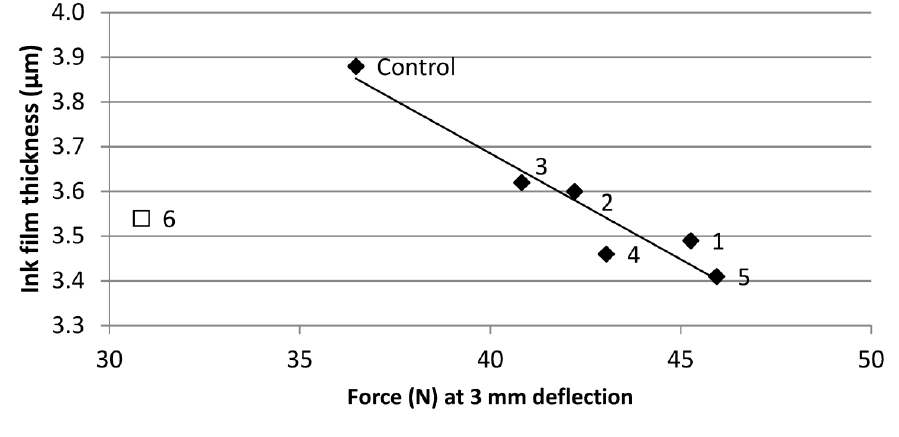
Figure 9. Ink film thickness vs . force required to deflect squeegee ( R 2 0.92 when Squeegee